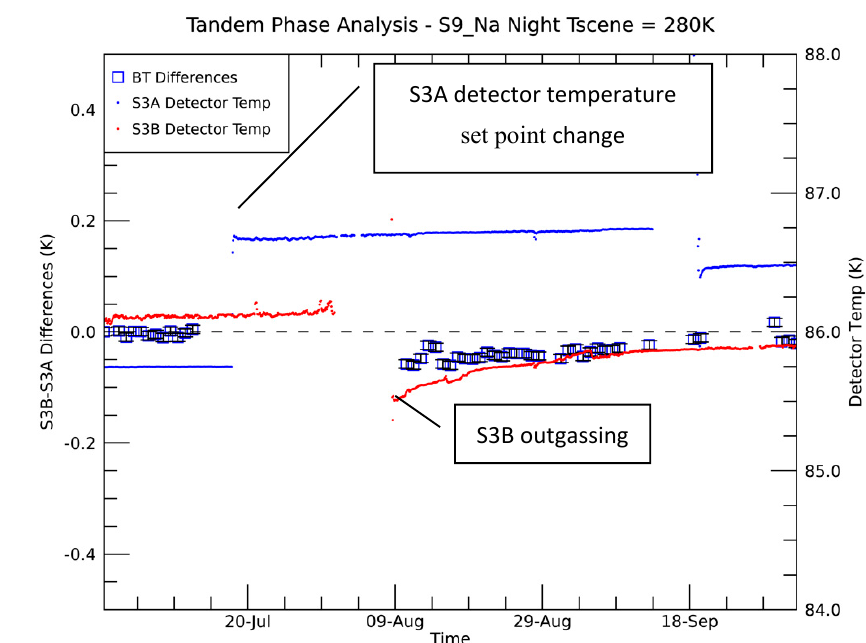
Figure 7. Time series of di ff erences between SLSTR-A and SLSTR-B for the S9 infrared channel in the nadir view for night-time data for 280 ± 0.5 K scenes during the tandem phase. The time series shows the coincidence of the evolution of the detector temperatures of the instruments and the measurement di ff erences. For SLSTR-A, the set point of the detectors is adjusted by 1 K, while for SLSTR-B, decontamination is performed, both for operational